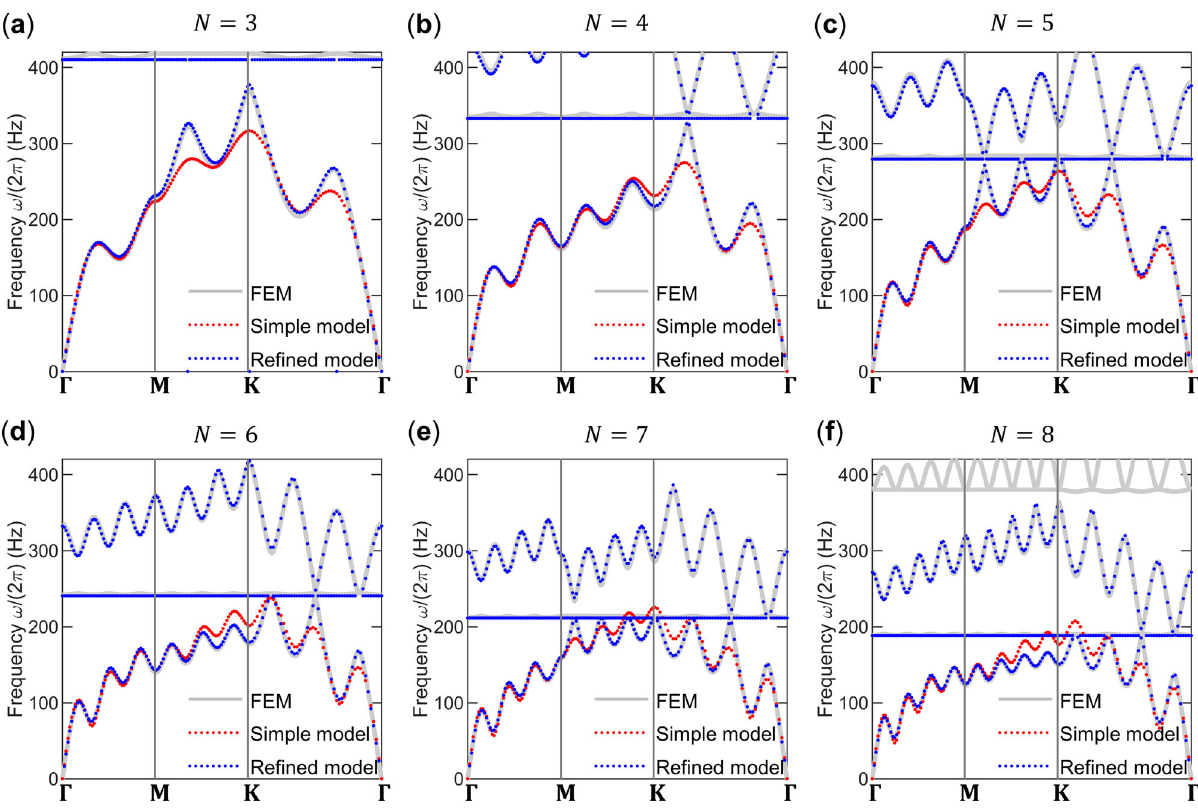
Fig. 4 Dispersion relations as in Fig. 3a, but for different orders N of beyond-nearest-neighbor interactions in addition to the nearest-neighbor interactions. a N ¼ 3. b N ¼ 4. c N ¼ 5. d N ¼ 6. e N ¼ 7. f N ¼ 8. The corresponding metamaterial structures are depicted in Fig.